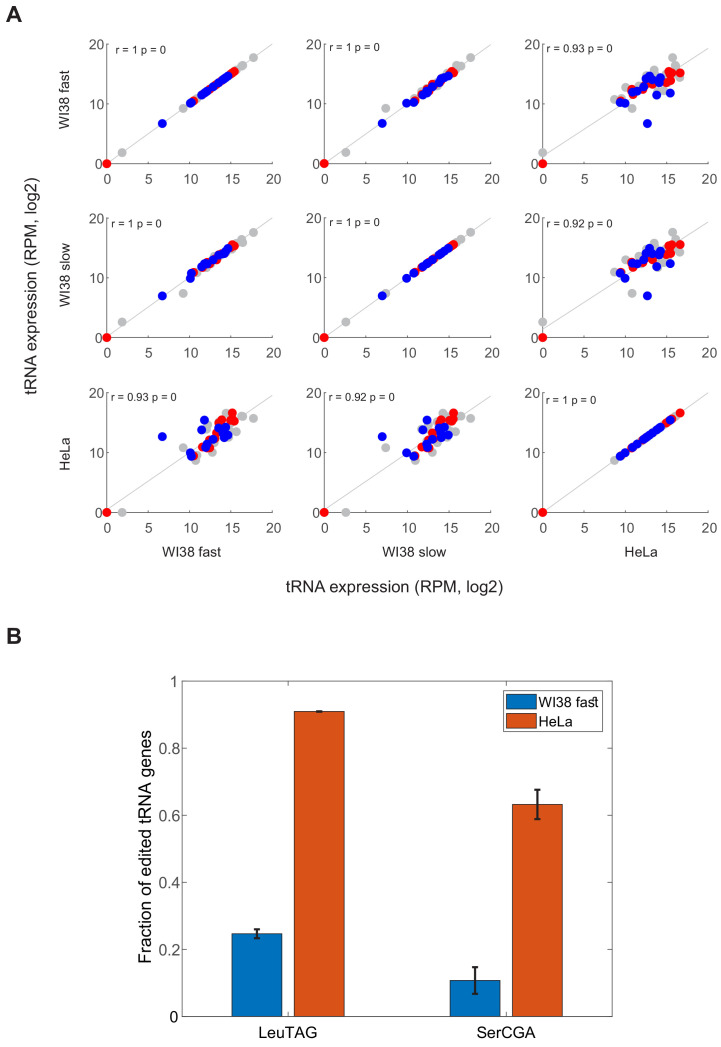
Comparison of tRNA expression and tRNA editing between cell lines.(A) Scatter plots representing the correlation between expression levels of the tRNA pool in WT WI38 fast, WI38 slow and HeLa cells, averaged over two biological repeats. Each dot is a tRNA family, while the expression is summed over all tRNA isodecoders that belong to the tRNA family (RPM), in log2. The colors depict the group of the tRNA family (red-proliferation-tRNAs; blue-differentiation-tRNAs; grey-other tRNAs). The Pearson correlation coefficient r and p-values are detailed for each scatter plot. (B) The maximal fraction of the edited tRNA genes from the total tRNA reads in tRNA-targeted WI38 fast and HeLa cells. For each cell line and sgRNA, the maximal fraction of targeted tRNAs was reached in a specific day of the iCas9 induction (LeuTAG, WI38 fast - day 8; LeuTAG, HeLa - day 4; SerCGA, WI38 fast - day 4, SerCGA, HeLa - day 8).